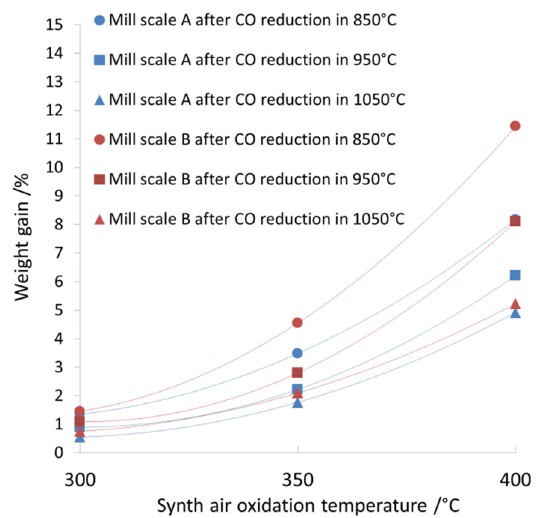
Figure 9. Mass increase during oxidation of samples at 300 °C, 350 °C, and 400 °C over 180 min— fractions A and B.